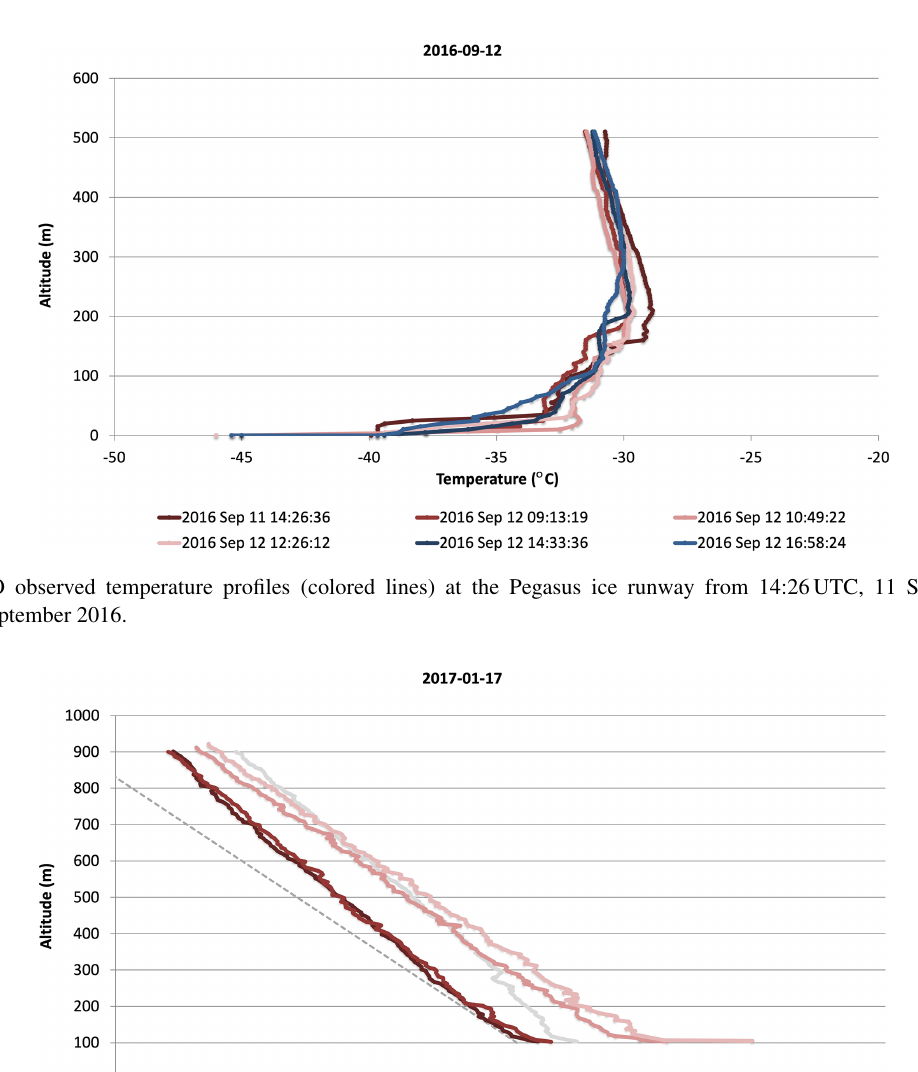
Valley was a deep convective boundary layer with a surface midafternoon local time (19:33 UTC, 17 January 2017, to 02:01 UTC, 18 January 2017), the boundary layer